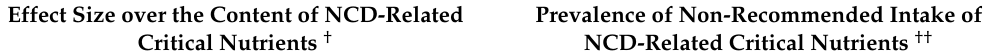
Table 4. Association between consumption of products with excessive content of NCD-related critical nutrients (grams) according to PAHO NPM, and the content provided by the respective nutrients † , and the prevalence of non-recommended intake of these nutrients in the whole diet ‡ . Effect Size over the Content of NCD-Related Prevalence of Non-Recommended Intake of Critical Nutrients †